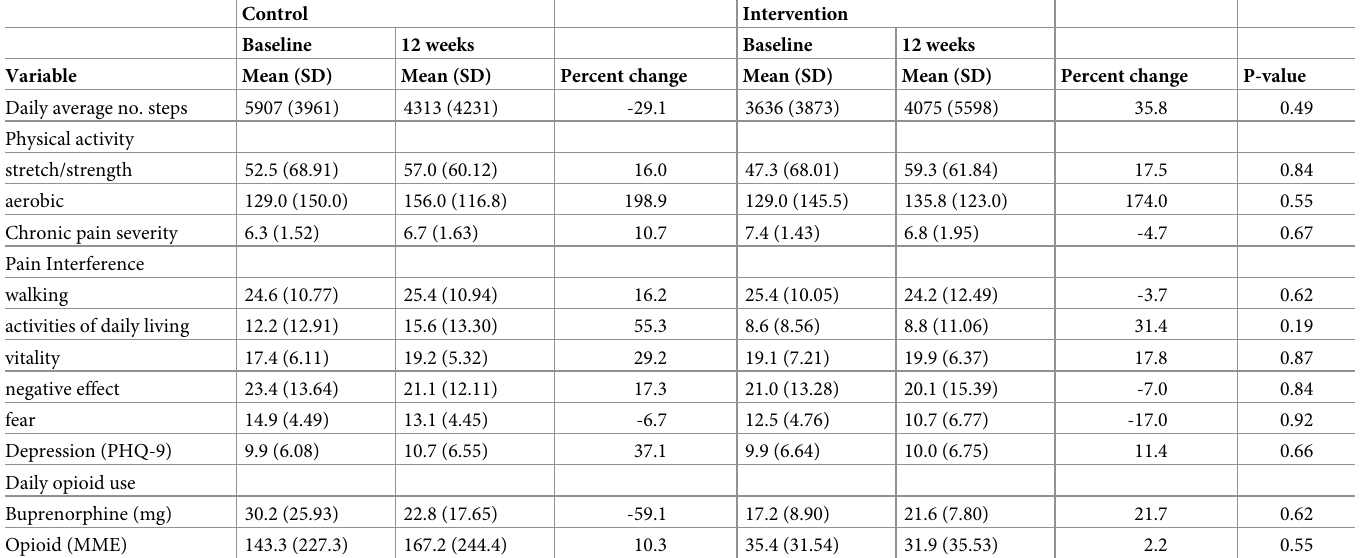
Table 5. Percent change in primary and secondary